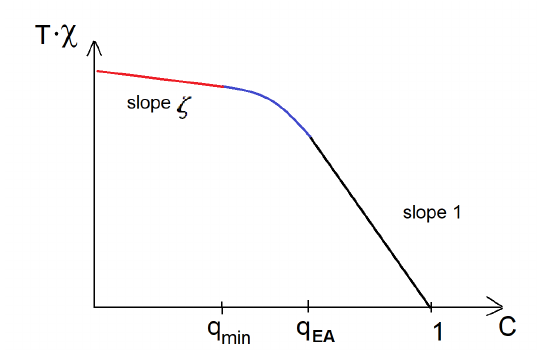
Figure 7: The χ vs. C curve for a system with couplings at temperature T curved part of the plot is almost independent of temperature, and the straight part matches tangentially the curved part. The transition in ζ takes place at the point where this tangent happens at the largest value C < q